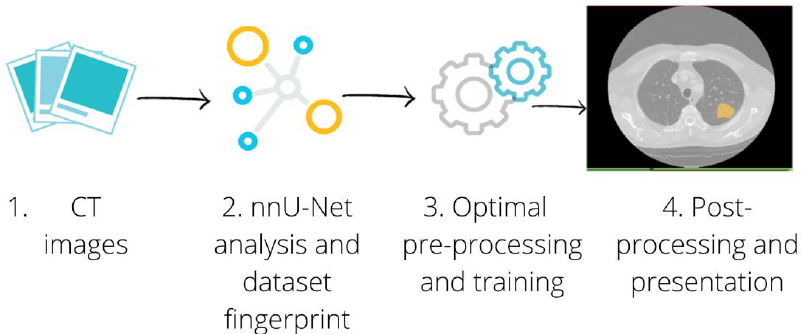
Figure 1. Segmentation Pipeline. The CT images of patients with a lung lesion were collected, along with the manual contours used as the ground truth ( 1 ). For each configuration we separated the cases into training and test set. The training set was passed through the nnU-Net framework ( 2 ), which automatically adapted the pre-processing to perform the optimal training ( 3 ). We finally applied the post-processing to the best performing model to present each connected component provided by the network separately ( 4 ).